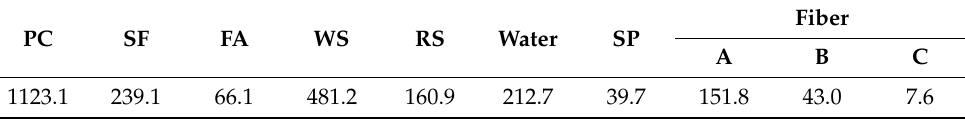
Table 4. Mix proportions of the developed UHPC (in kg/m 3 ).